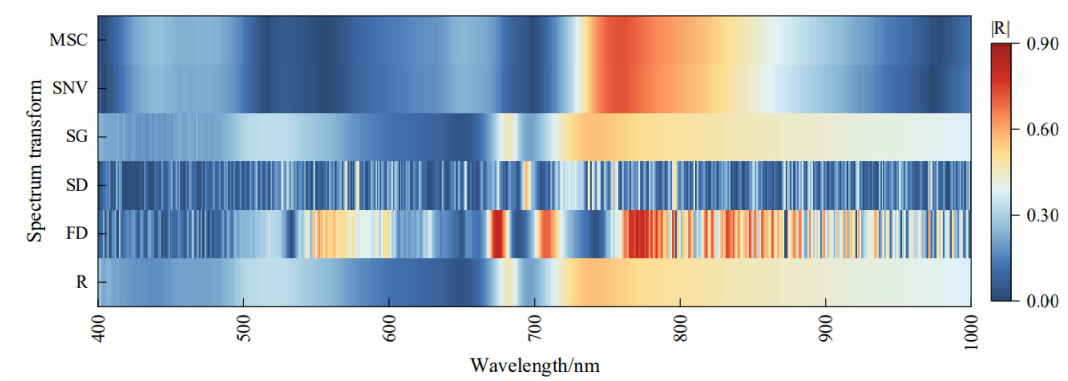
Figure 3. |R| between Fv/Fm and spectral reflectance under different spectrum